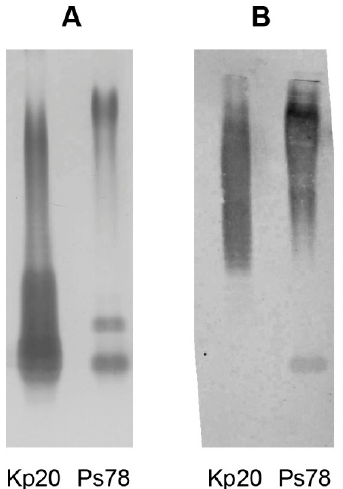
Figure 4. SDS-PAGE analysis and reactivities of P. shigelloides serotype O12-specific polyclonal antibodies with LPSs of P. shigelloides 78/89 and K. pneumoniae Kp20 in immunoblotting. LPSs of P. shigelloides 78/89 (Ps78) and K. pneumoniae Kp20 (Kp20) were analyzed by SDS-PAGE (1.25 µg/lane) using 15% separating gel and visualized by silver staining method ( A ) or transblotted onto nitrocellulose ( B ). Polyclonal antibodies specific for the O12 serotype were 200-fold diluted.